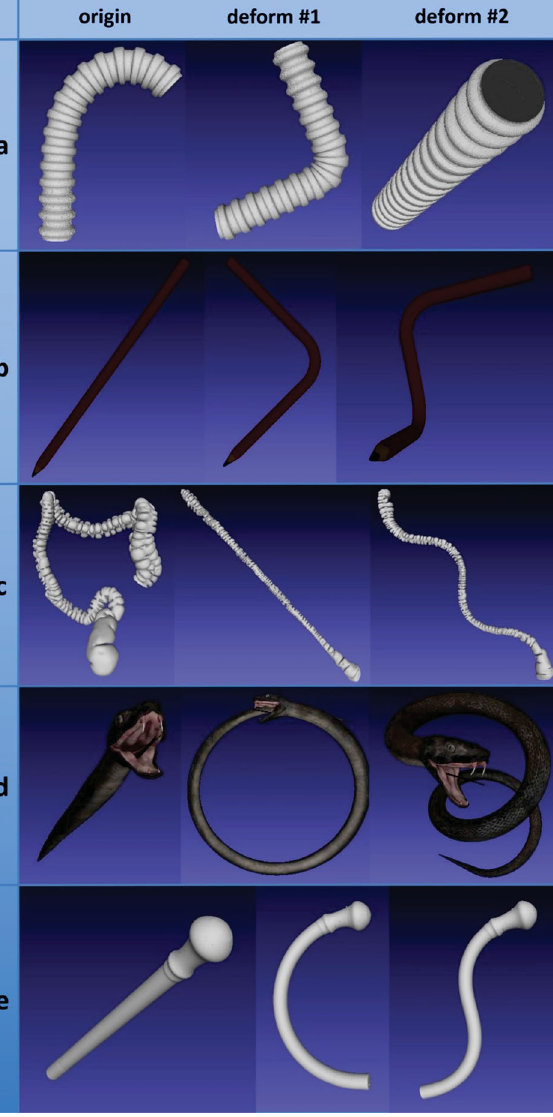
Fig. 9 Deformation (left to right) of a human colon. The blue disks show corresponding positions of a high curvature region. Cross- sectional intersections are prevented, and local curvature patterns are preserved.